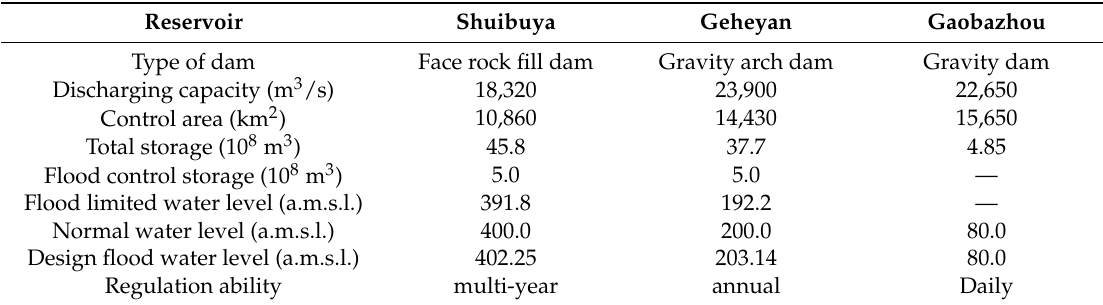
Table 1. List of characteristic parameter values of the Qinjiang cascade